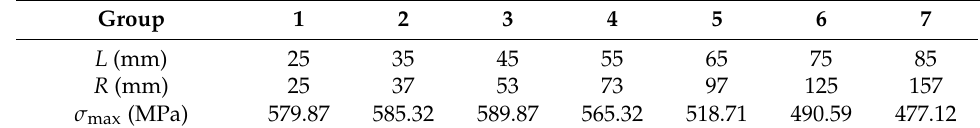
Table 2. Stress values of different transition arc parameters.